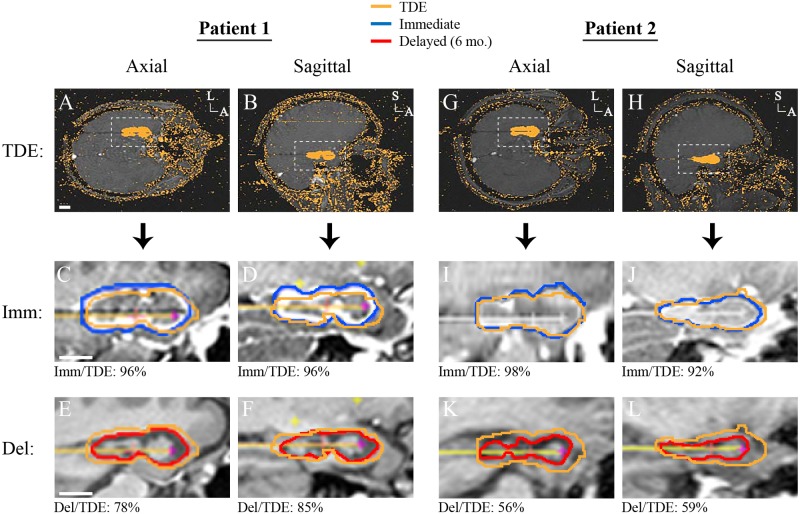
Overlap of TDE maps with immediate and delayed ablation zone boundaries.(A-B) Axial and sagittal TDE maps at the end of the LITT procedure for sample Patient 1. The white dashed boxes show the regions highlighted in the panels below. (C-D) Axial and sagittal post ablation contrasted T1 images showing the manually-traced immediate ablation zone (blue) and the boundary of the TDE (yellow) from the same imaging plane. The numbers below the image panels show the DSC values. (E-F) Axial and sagittal T1 MP-RAGE images 6-months after surgery demonstrating the manually-traced delayed ablations (red) and the TDE (yellow). (G-L) Same conventions as A—F but for Patient 2. A, anterior; Del, delayed; Imm, immediate; L, lateral; S, superior; TDE, thermal damage estimate.